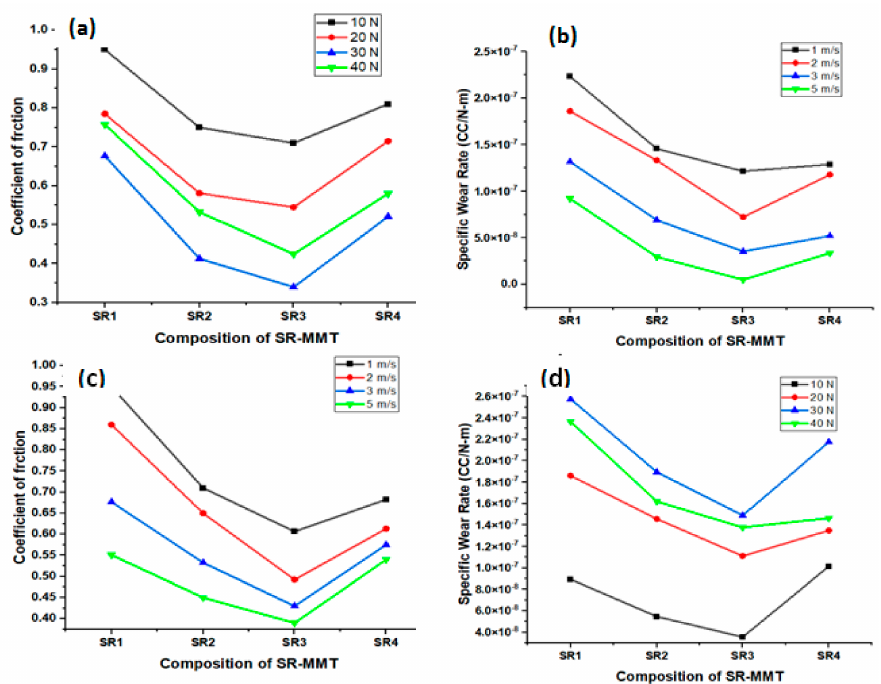
Figure 9. Variation of ( a ) Coefficient of friction (COF), ( b ) Specific wear rate for all compositions at different loads, and ( c ) Coefficient of friction (COF) ( d ) Specific wear rate for all compositions at a different sliding